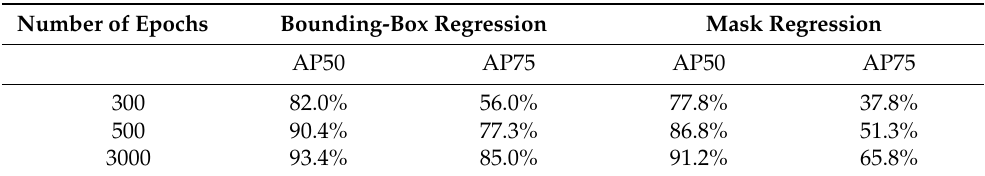
Table 1. Performance metrics of the segmentation process (on the validation set) vs. the training epochs (objectness score threshold =